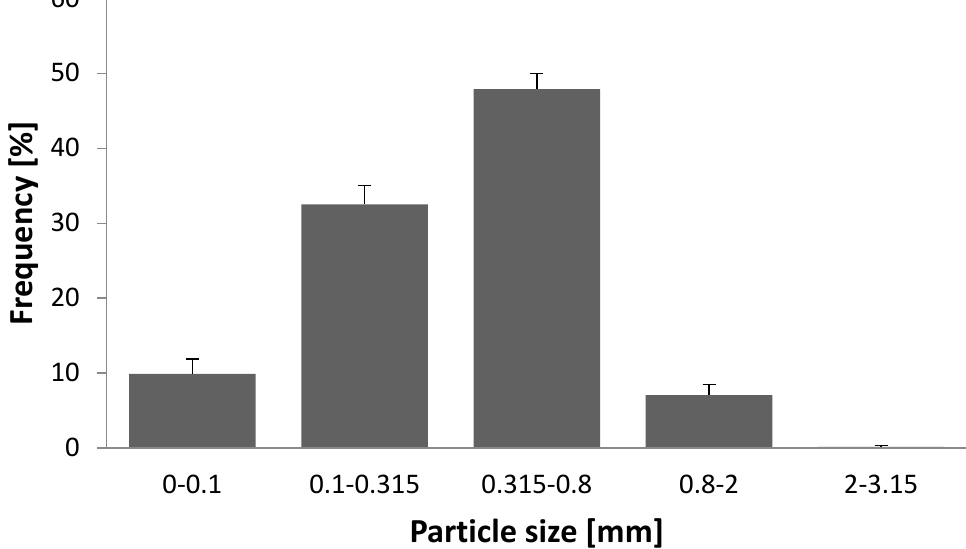
Figure 1. Particle size distribution of ground peppermint leaves.